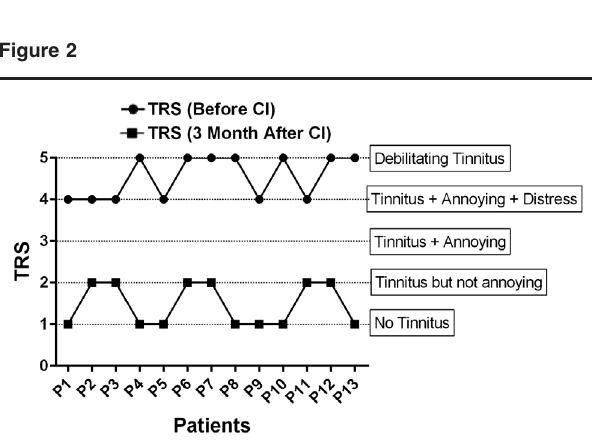
Tinnitus severity rating for each patient in the study group before and after cochlear implantation (CI). TRS, Tinnitus Rating Scale.